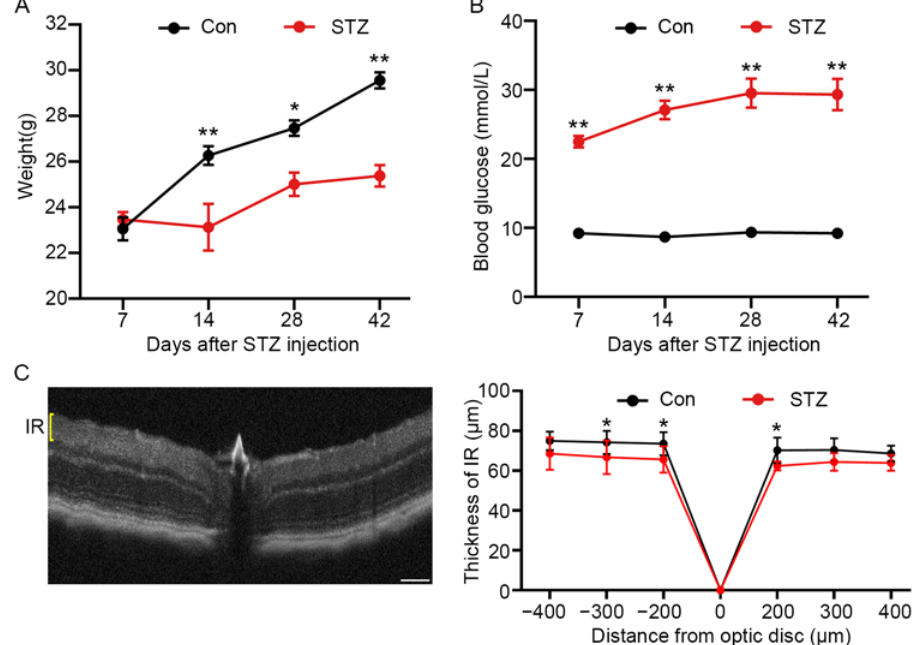
Figure 1. The establishment of STZ-induced diabetic mice retinas. ( A ) Body weight (g) of all mice from two groups. Data are presented as mean ± SEM, * p < 0.05, ** p < 0.01, n = 9 in the control group, n = 9 in the diabetic group. ( B ) Blood glucose (mmol/L) of all mice from two groups. Data are presented as mean ± SEM, * p < 0.05, ** p < 0.01, n = 9 in the control group, n = 9 in the diabetic group. ( C ) Representative image of a 15-week STZ-induced diabetic mouse retina captured using OCT showing the IR and quantification of 12 images from each group is represented in the line graph. The thickness of the inner retinal layer was reduced in the diabetic retina compared to the controls. Data are presented as mean ± SEM, n = 12 eyes per group. Scale bar, 120 μm. IR, inner retina.